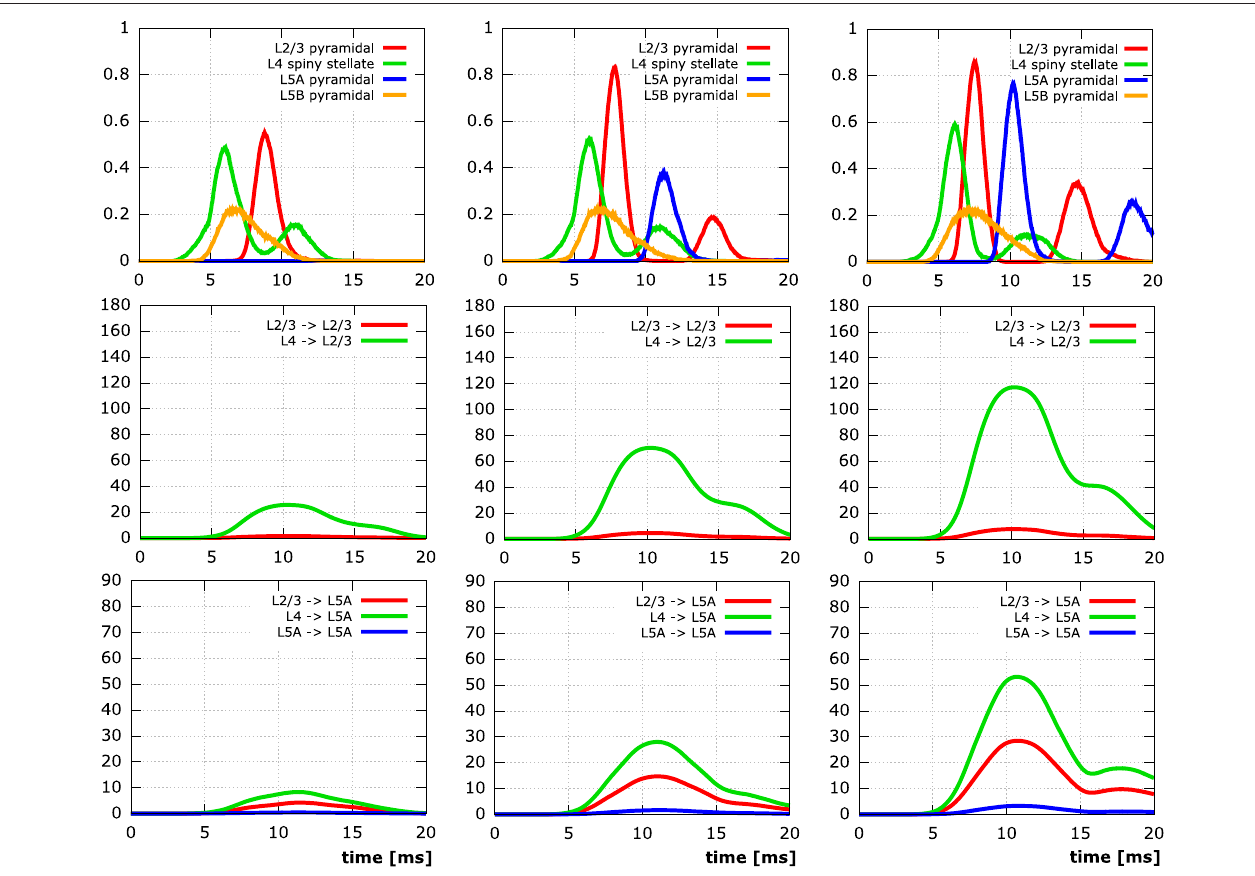
FIGURE 9 | Simulation results for networks of 10,000 neurons. The columns contain time plots for networks created with a synapse creation distance of 2 µ m , 3 µ m , 4 µ m (FLTR), respectively. Row 1: Relative number of active somata, i.e., V 45 mV , in different levels (L2/3 red, L4 green, L5A blue, L5B orange). Row 2: ≥ − Number of active synapses at L2/3 pyramidal neurons originating from different levels (L2/3 red, L4 green). Row 3: Number of active synapses at L5A pyramidal neurons originating from different levels (L2/3 red, L4 green, L5A blue). Initial activation of L4 spiny stellate and L5B pyramidal cells by the same thalamic input pattern in all simulations.